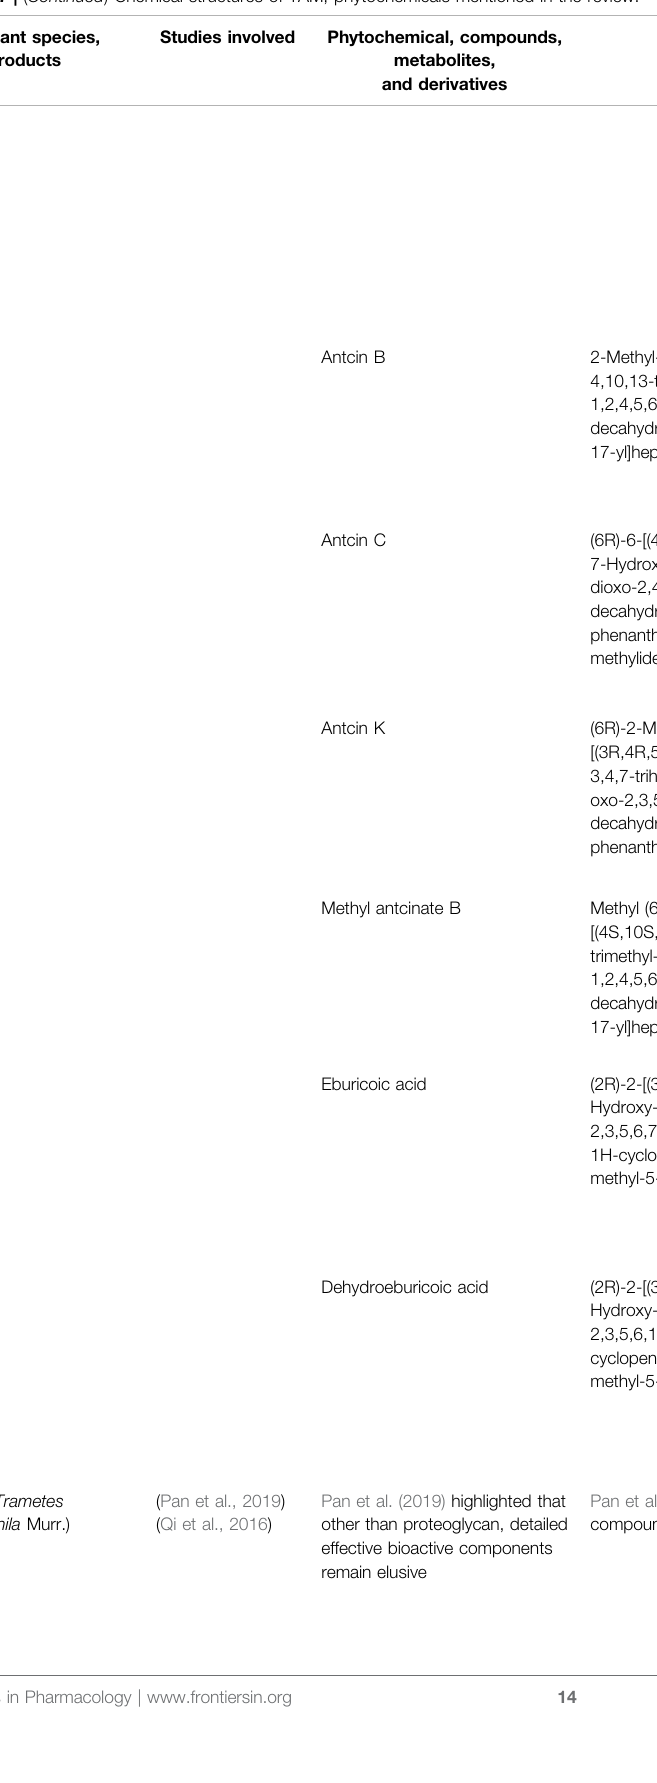
TABLE 7 | ( Continued ) Chemical structures of TAM, phytochemicals mentioned in the